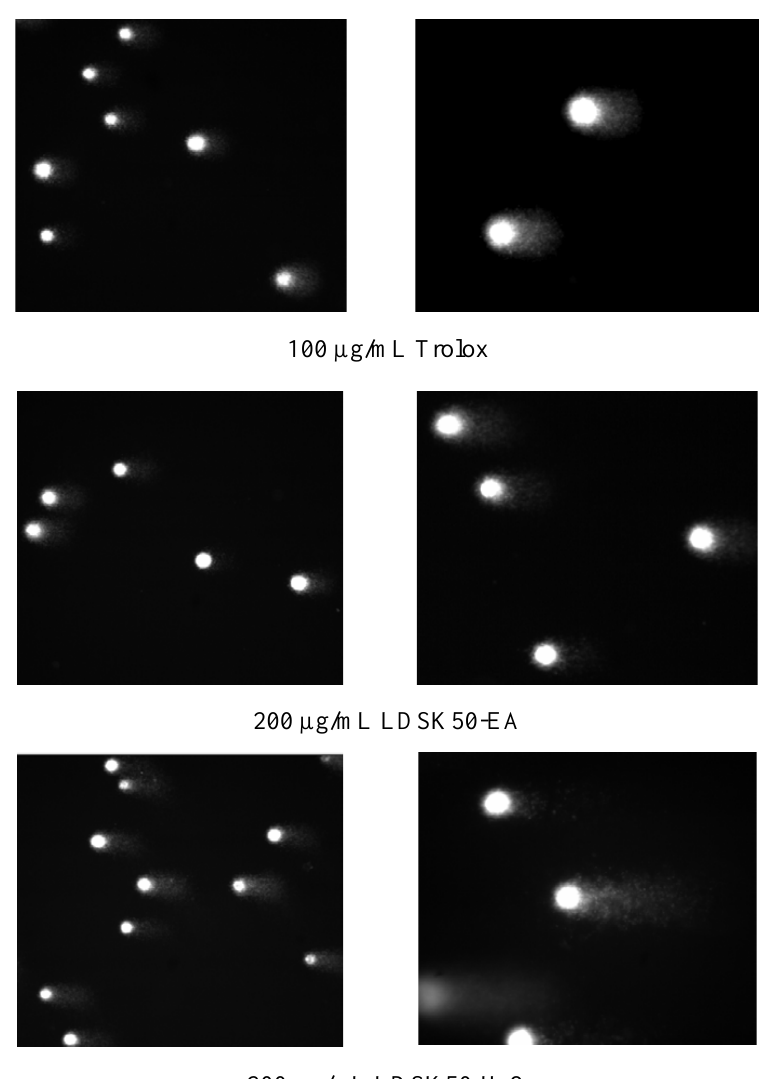
Figure 5. The comet images of TK6 cells (from top to bottom) of the following treatments: control or untreated (undamaged DNA), 50 µM H 2 O 2 , 100 µg/mL Trolox (positive control), 200 µg/mL LDSK50-EA, and 200 µg/mL LDSK50-H 2 O. Cells